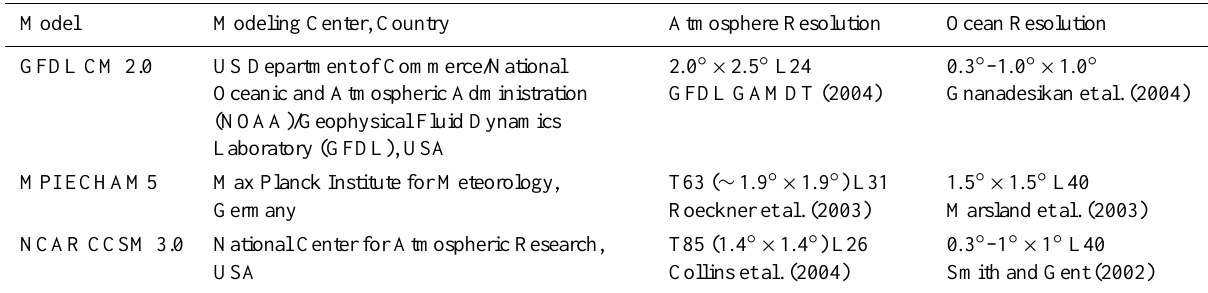
Table 1. Three AOGCMs used in the IPCC AR4. T indicates the horizontal resolution using spectral truncation. L indicates the number of levels used in the